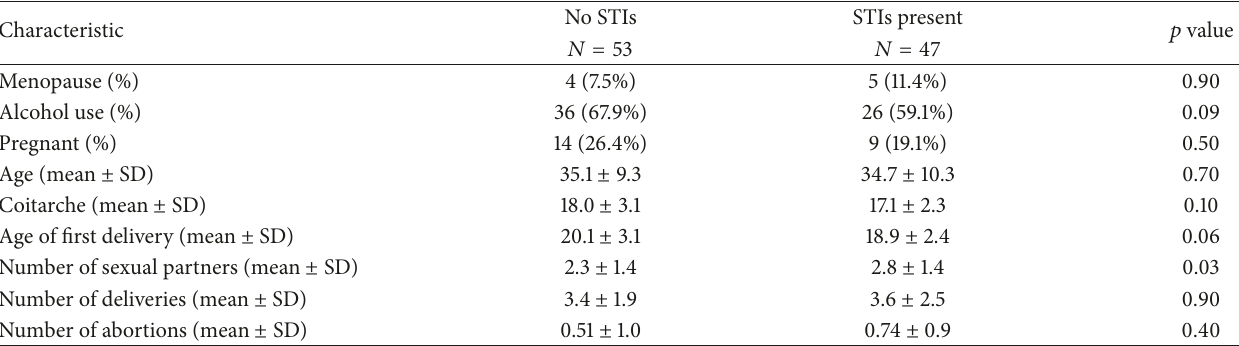
Table 3: Epidemiology and risk factors for STIs (HPV, HIV, CT, TV, or NG positive) of 100 unselected women presenting for Pap smear in the remote isolated population of Pr´ıncipe Island. Pearson 𝜒 2 Fisher exact test and Mann-Whitney 𝑈 test were used. Characteristic